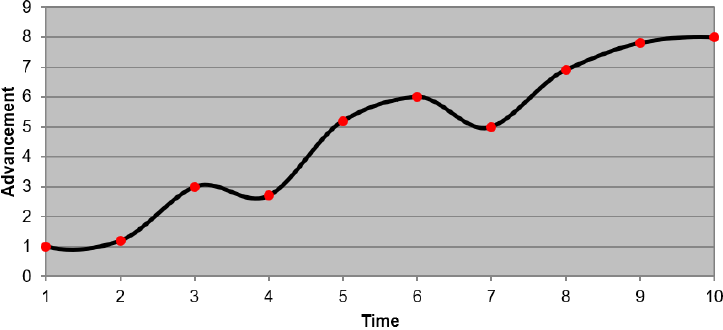
Fig. 1. Development of a